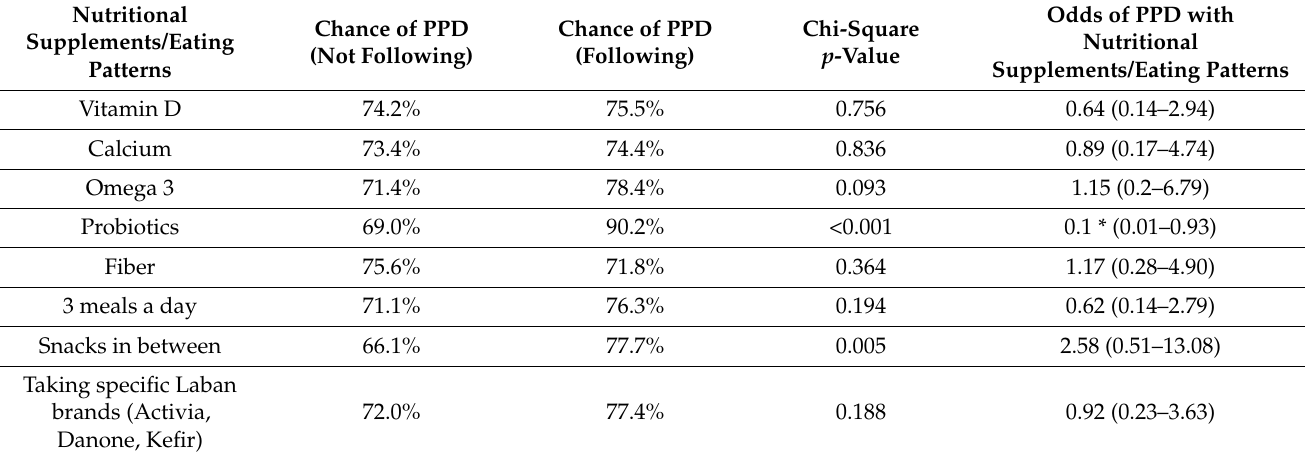
Table 4. The association between the intake of nutritional supplements/eating patterns and